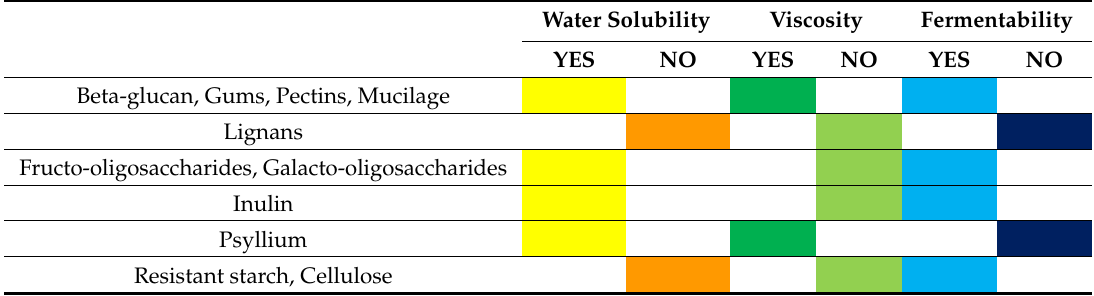
Table 3. Main fibers physicochemical characteristics (data derived from O’Grady [28]).